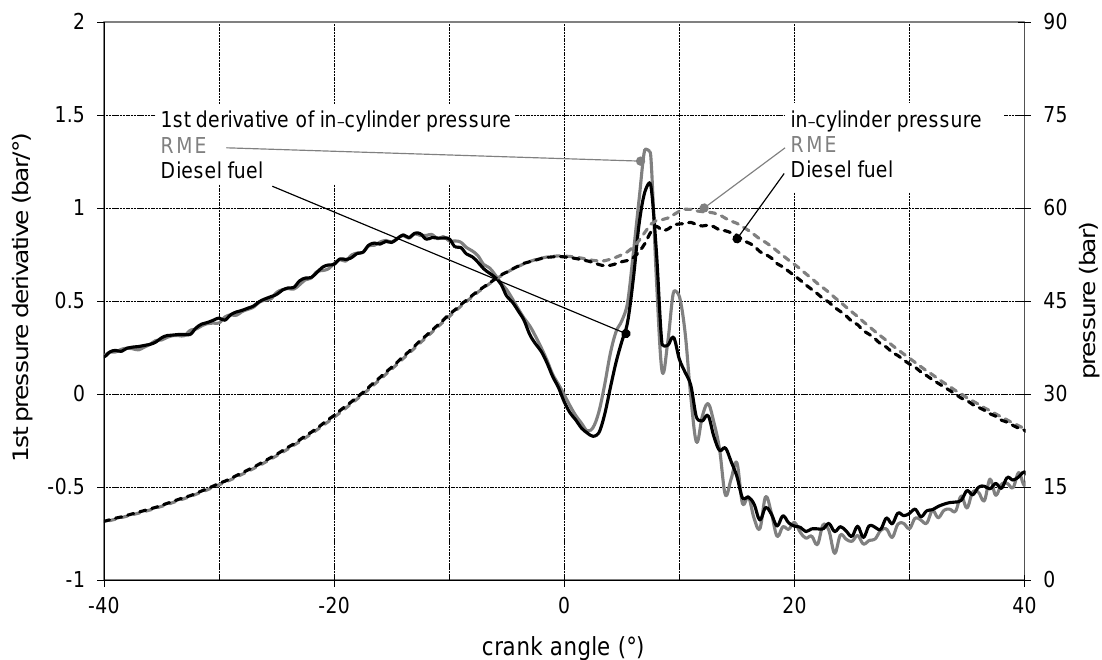
Figure 17. RME and diesel fuel in-cylinder pressures and rate of pressure rise at 2500 rpm and at full load.